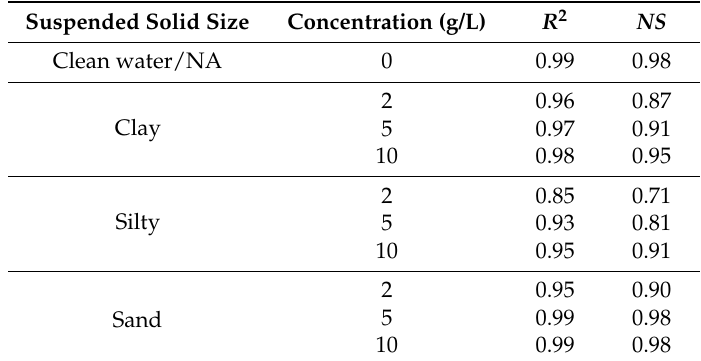
Table 6. Goodness-of-fit, represented by R 2 and NS , calculated on basis of the observed and reconstructed infiltration rate under the defined treatments.